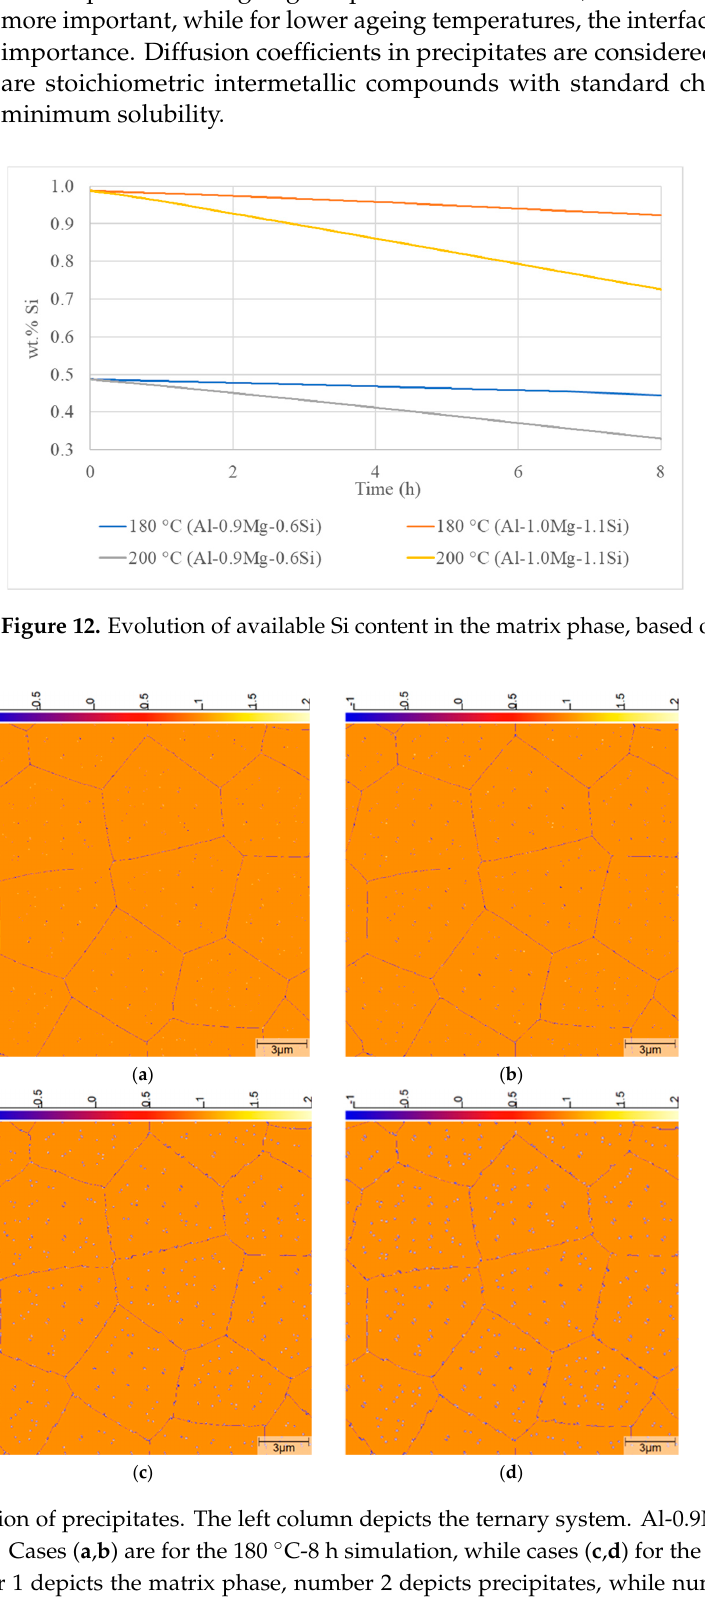
Figure 11. Temporal evolution of Mg and Si content in the matrix phase.